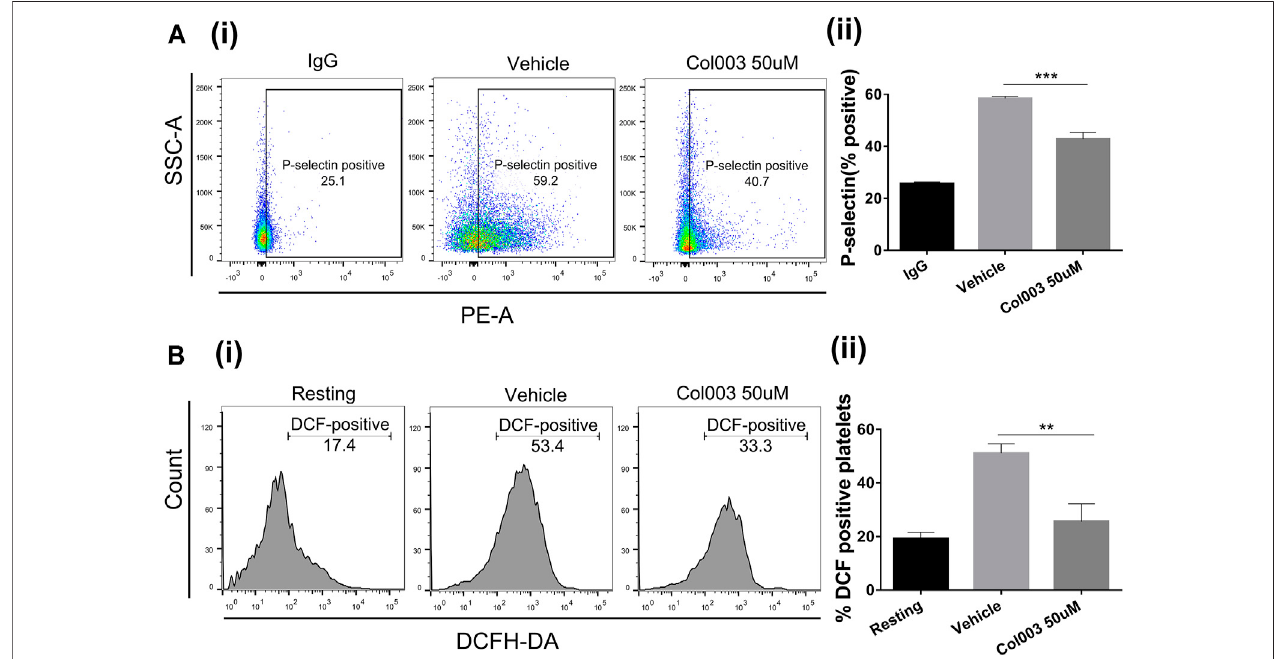
FIGURE 3 | Effects of Col003 on P-selectin expression and ROS generation induced by collagen in rat platelets. (Ai) Representative scatterplots of P-selectin expression inIgG(negativecontrol), vehicle,andCol003-treatedplatelets (Aii) Thepercentage ofP-selectin – positiveplateletswerequanti fi ed.The%P-selectin – positive platelets in three different groups were 25.73 ± 0.35% (IgG), 58.43 ± 0.50% (Vehicle), 42.83 ± 1.49% (Col003), respectively. (Bi) Flow cytometry of DCHF-DA – loaded platelets in washed platelets treated with either vehicle or Col003 showing collagen-induced ROS generation. (Bii) The percentage of DCF-positive platelets was quanti fi ed. The %DCF-positive events in different three groups were 19.30 ± 1.31% (Resting), 51.08 ± 1.74% (Vehicle), 25.60 ± 3.85% (Col003 50uM), respectively. Statistical analysis was performed with unpaired two-tailed Student ’ s t -test (** p < 0.01 and *** p <